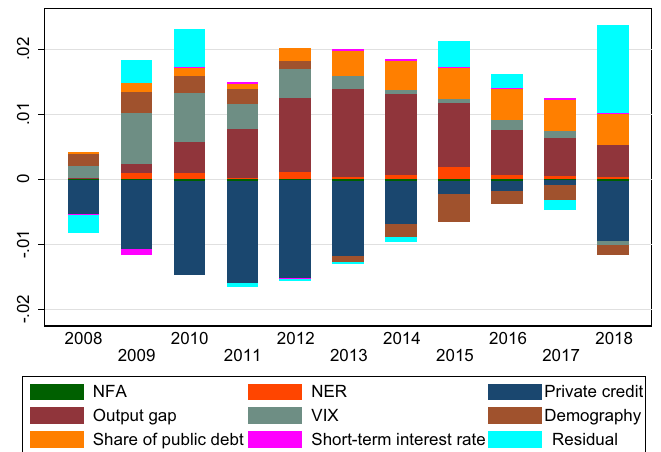
Fig.11 Accumulated correction of the Spanish investment income balance: extension to 2018. Notes. This figure plots the detailed decomposition of the adjustment in the Spanish investment income balance over the period 2008–2018 with the contribution of each of the regressors included in Table 3